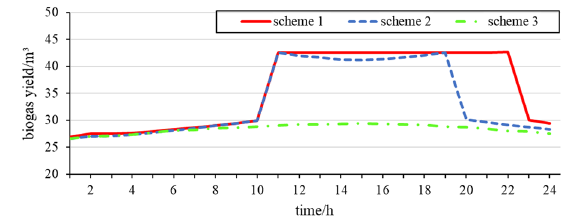
Fig. 17 Biogas yield in summer